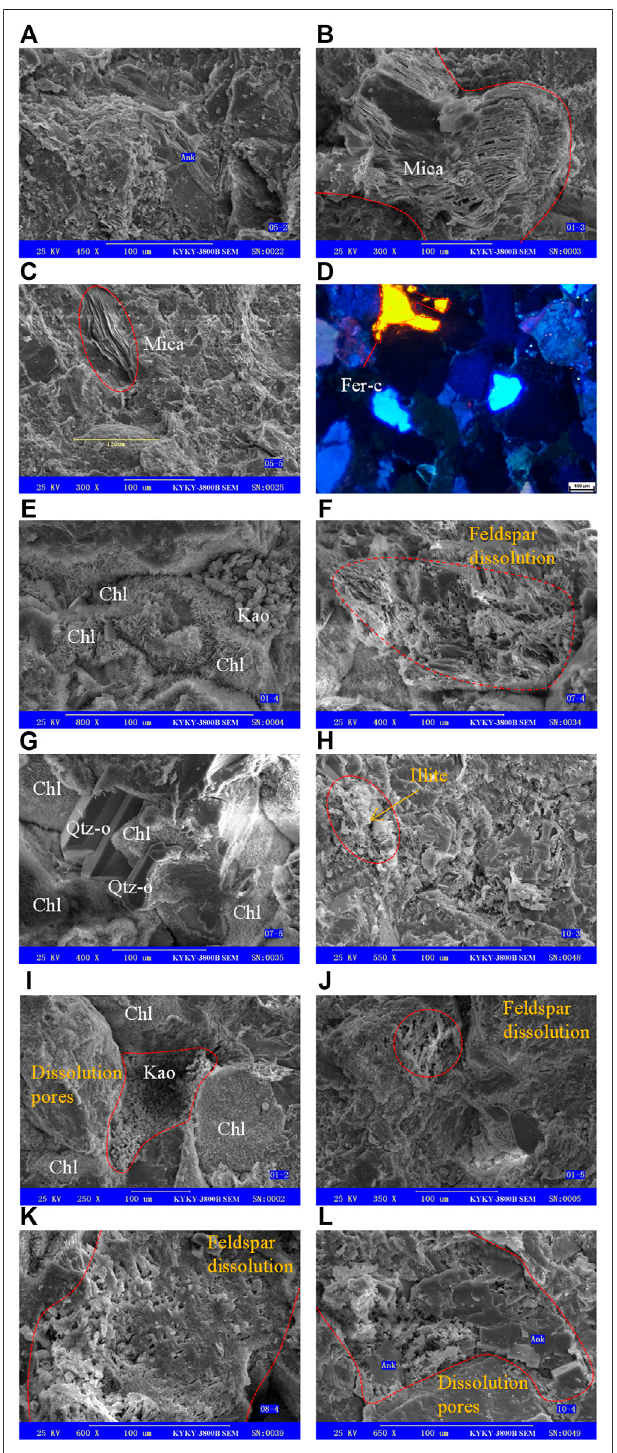
FIGURE 5 | SEM image and cathodoluminescence (CL) image showing the optical characteristics of diagenesis in the FGSR reservoir. (A) Sample 2461.5 m, well Z156: primary pores were destroyed by mechanical compaction. (B) Sample 2384 m, well Y72: mica was deformed by mechanical compaction. (C) Sample 2461.5 m, well Z156: mica was